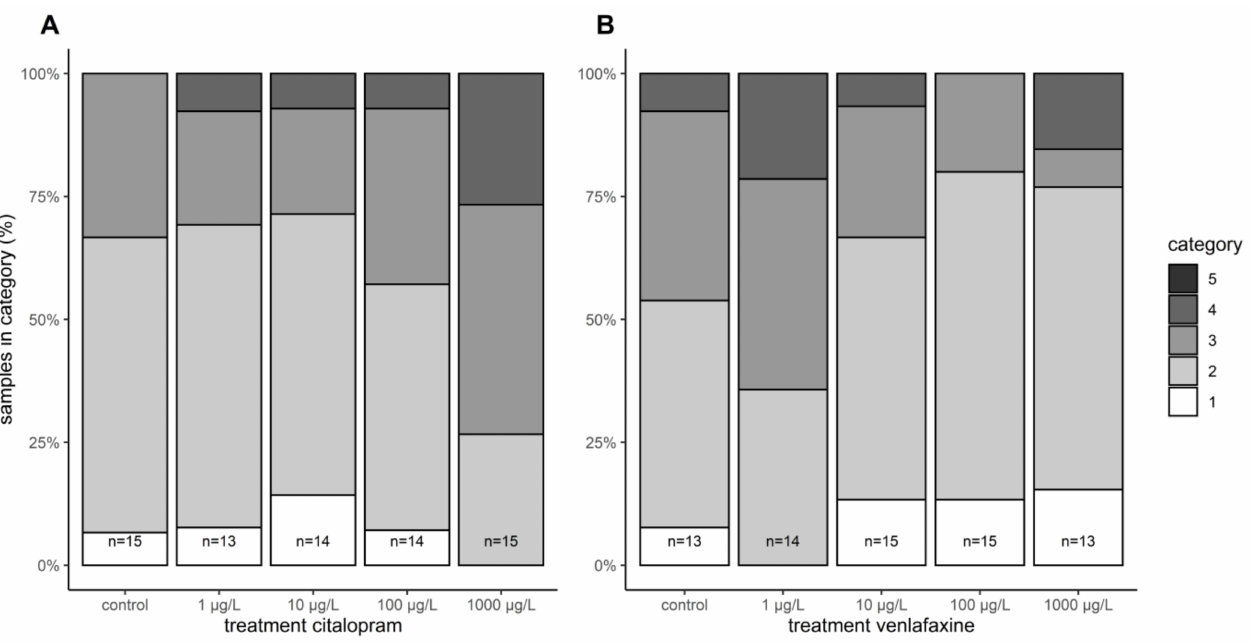
Figure 2. Semi-quantitative assessment of the hepatopancreas status of big ramshorn snail. ( A ): experiment with citalopram, ( B ) experiment with